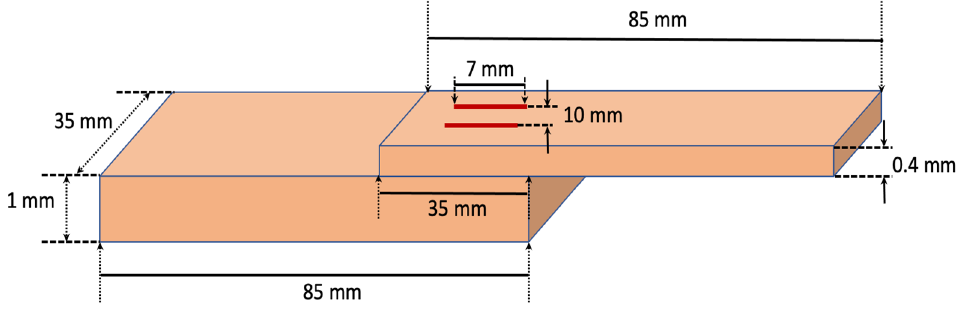
Figure 3. Schematic arrangement of coupons in a lap-joint configuration for tensile lap shear tests.